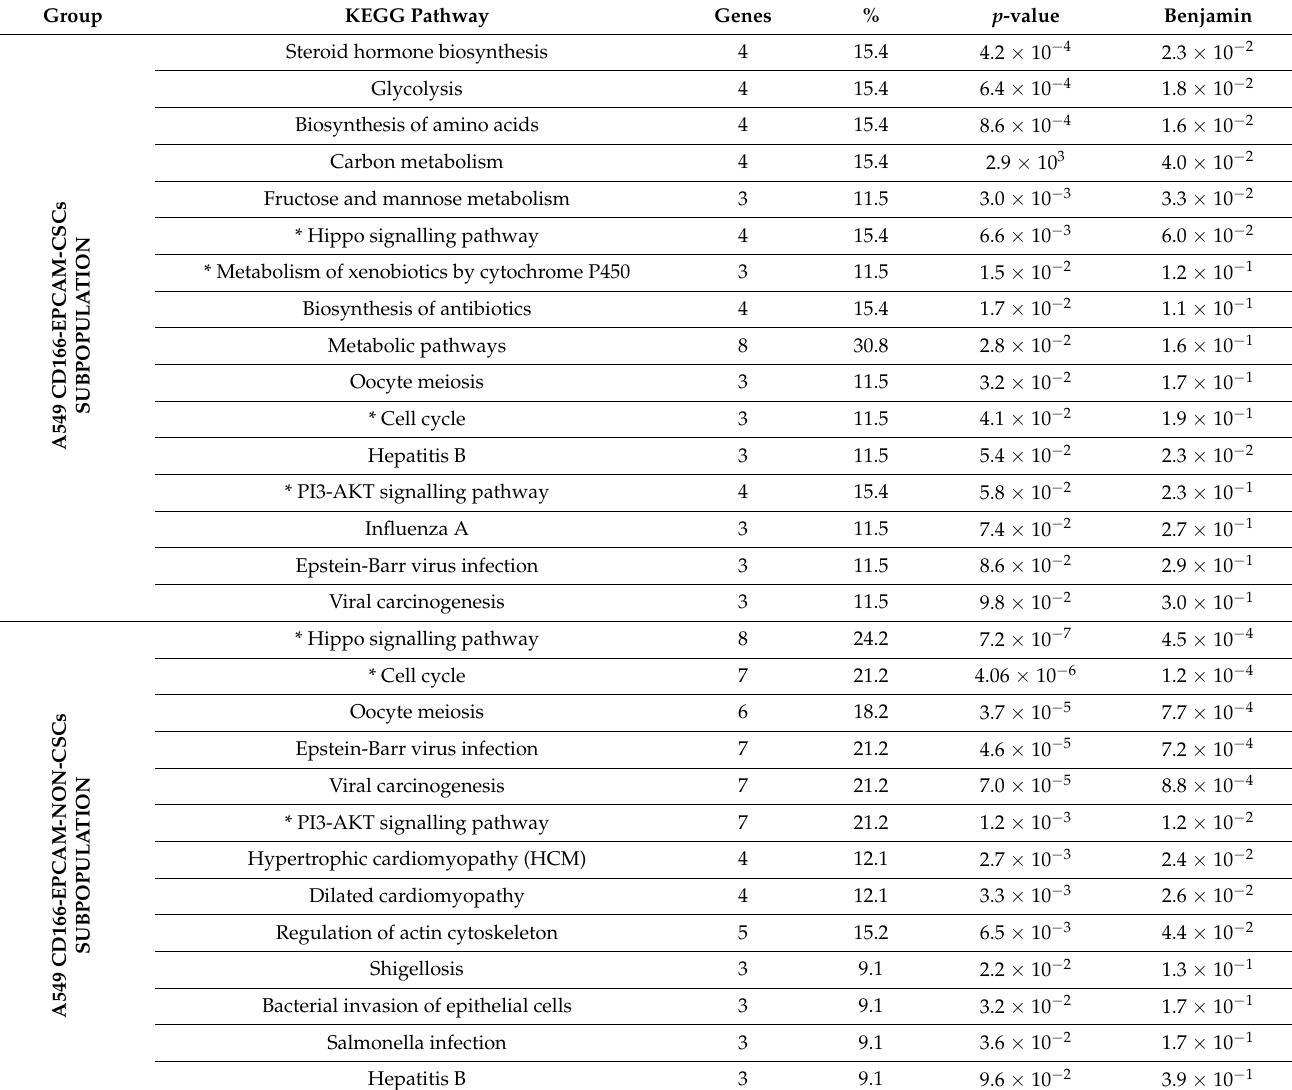
P450 (Table 1). clearpage Table 1. KEGG pathways related to CD166+EpCAM+ CSCs subpopulation and CD166-EPCAM- non- CSCs subpopulation of A549 cell